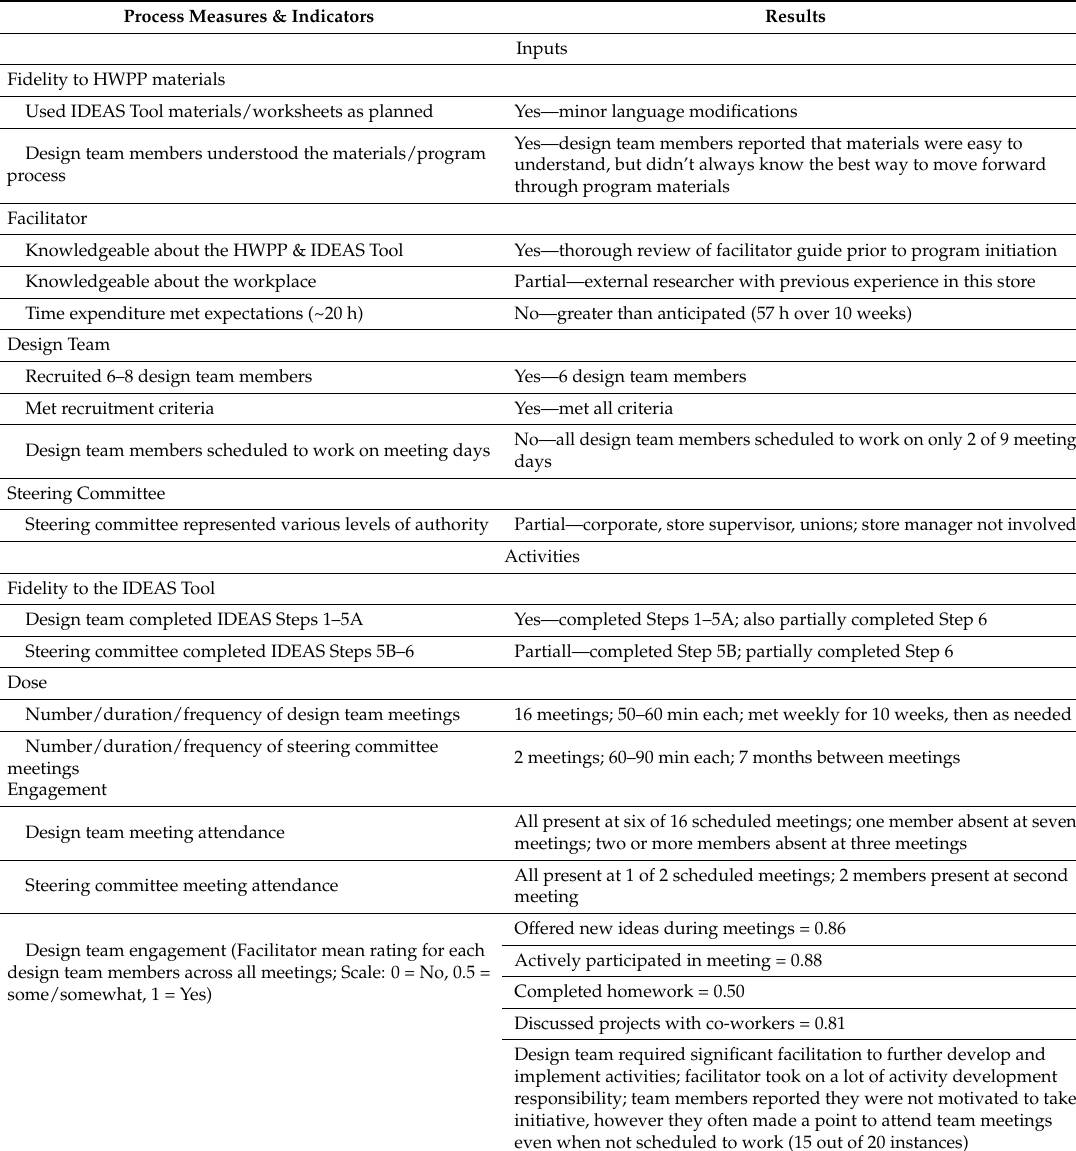
Table 2. Participatory Health Program Process